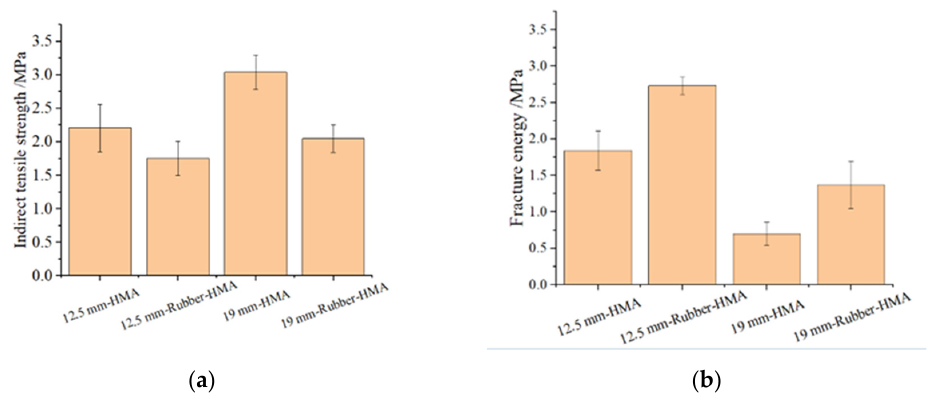
Figure 10. IDT strength and failure energy results. ( a ) IDT strength test data; ( b ) failure energy results.